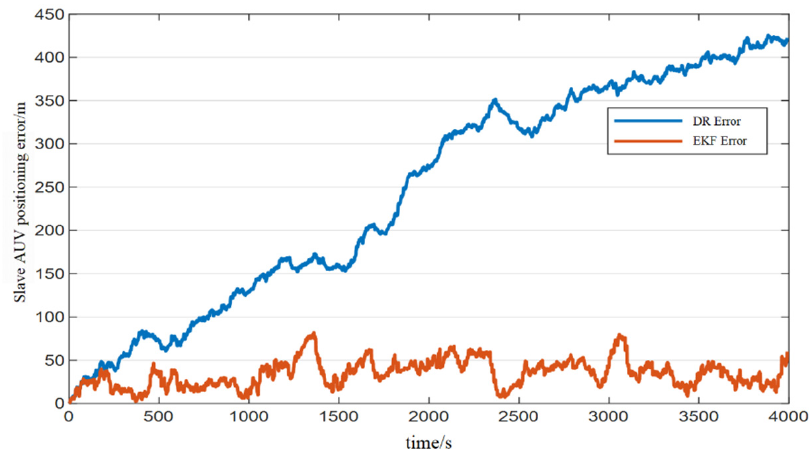
Figure 18. Positioning errors of the slave AUV based on EKF.